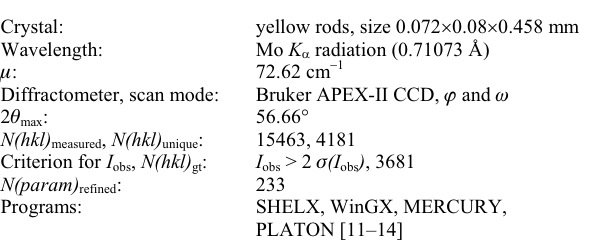
Table 1. Data collection and